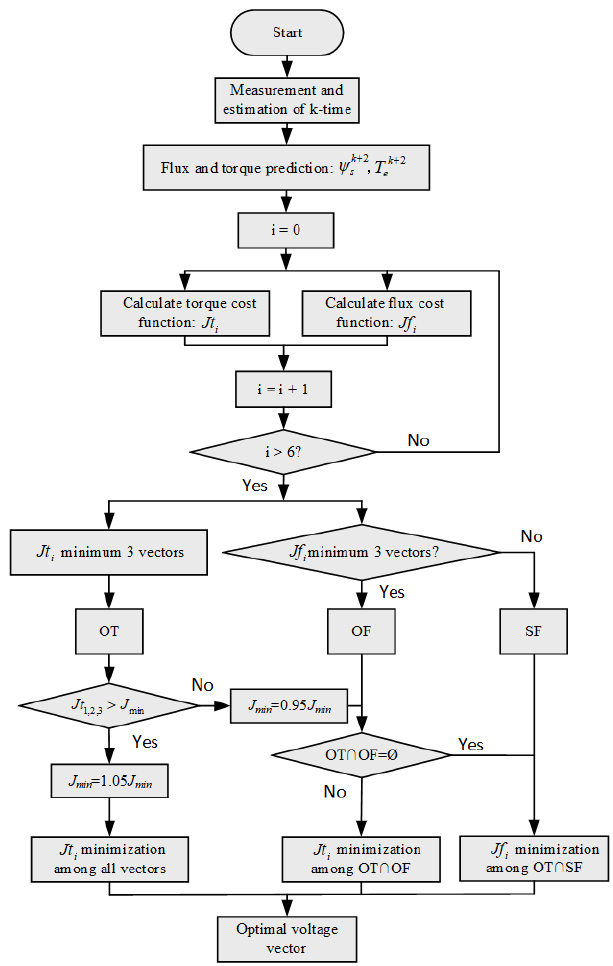
Figure 3. The control flow chart of the proposed